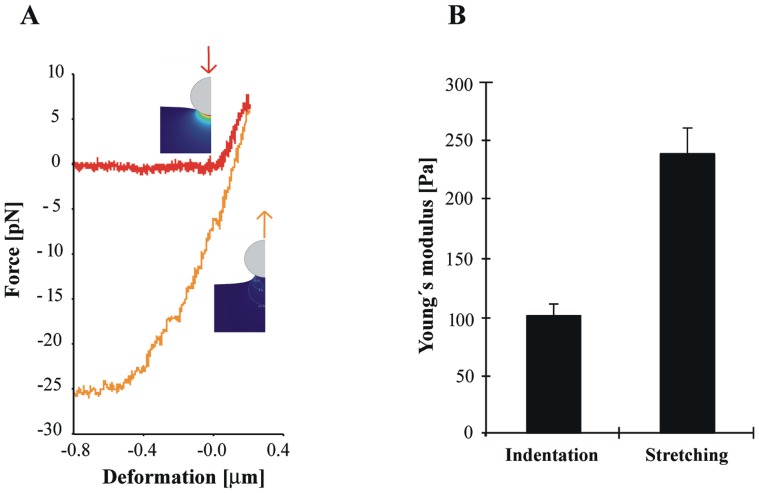
Cell stretching experiments. A)Beads that got stuck during cell indentation were used as a handle to stretch the cell. The stretching curve (orange) is steeper than the indentation curve. B) The Young’s modulus that is estimated from the stretching experiments is about twice as high (239 Pa) as the modulus we calculated from the indentation experiments (100 Pa).